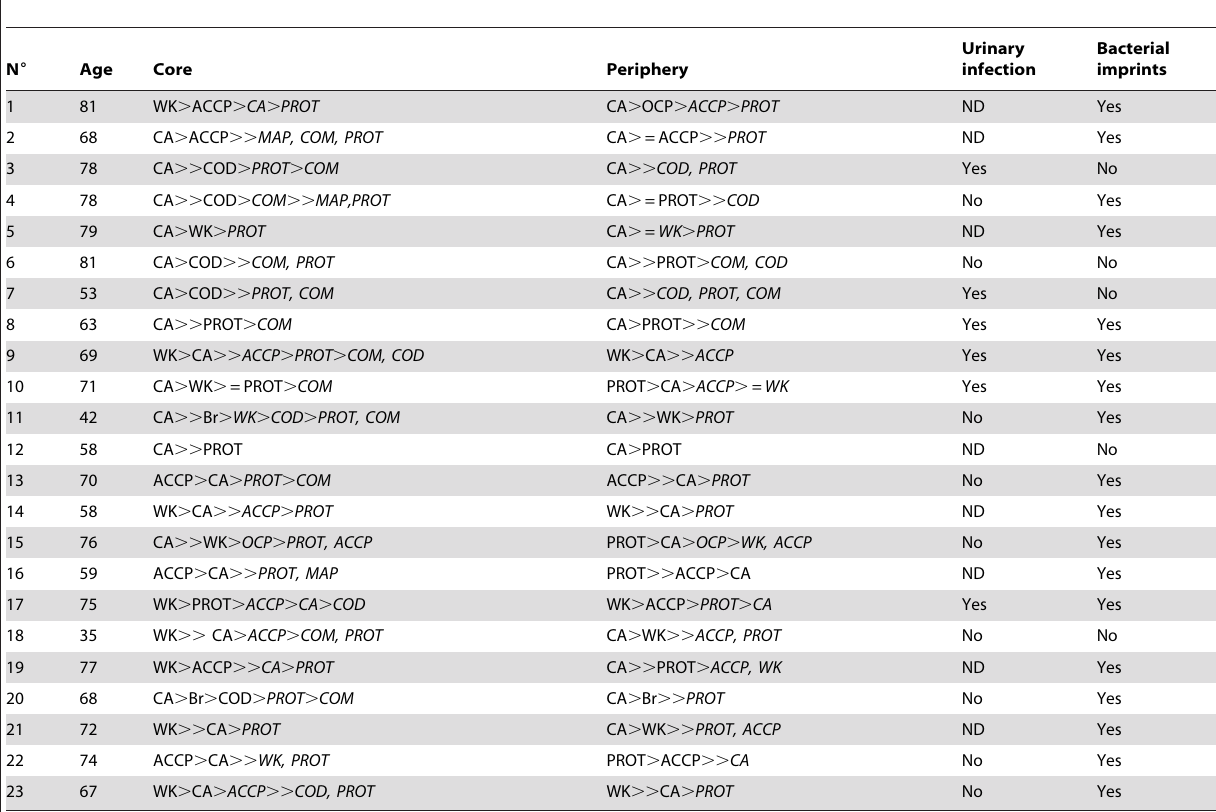
Table 1. Major phases in inner and peripheral layers (minor phases in italics) in 23 samples of prostate stones, along with presence of urinary infection and bacterial imprints.